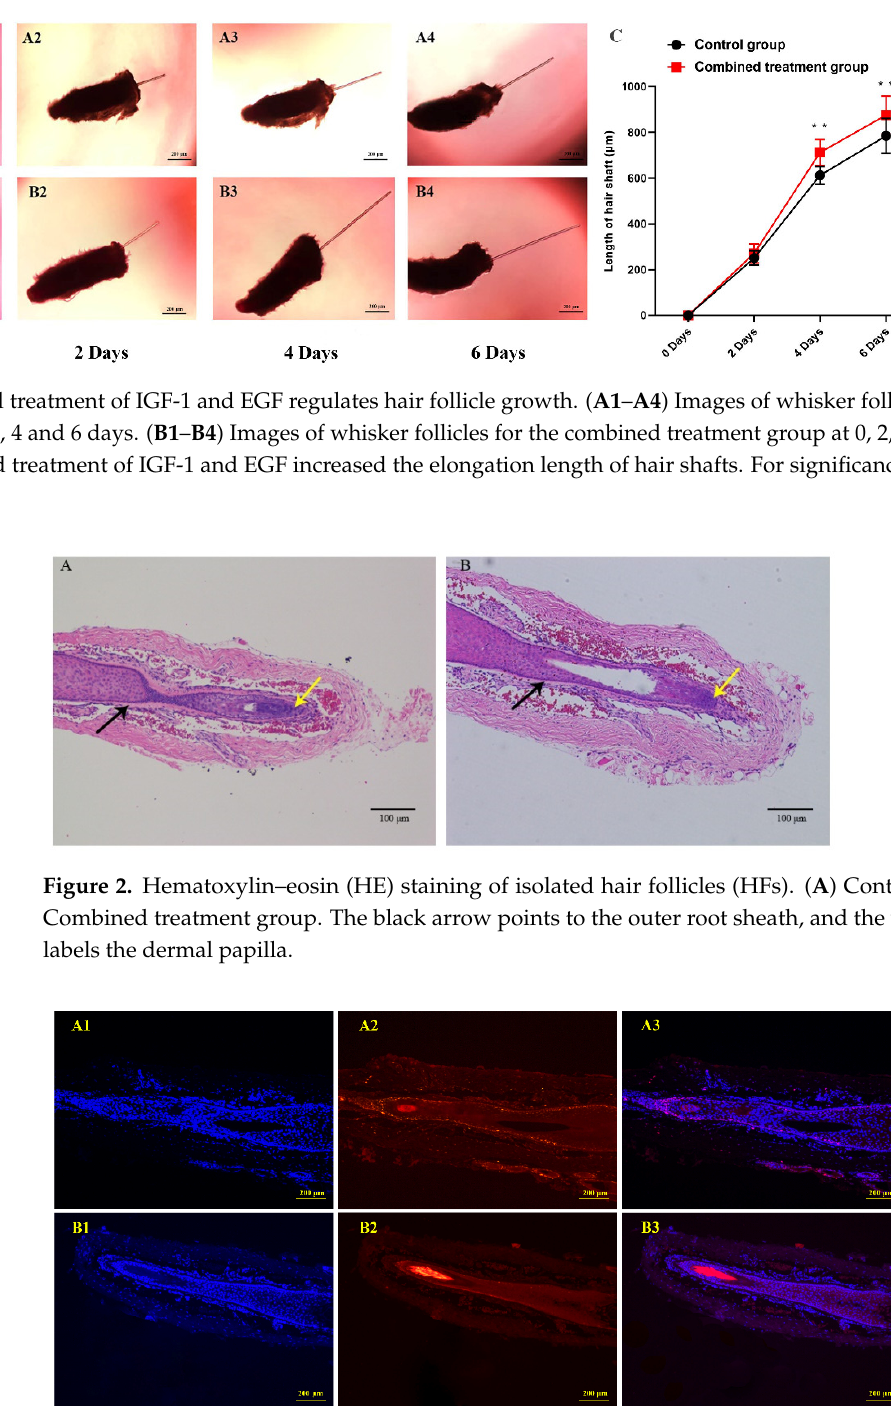
Figure 3. Immunofluorescence analysis of isolated HFs. ( A1-A3 ) Control group ( B1-B3 ) Combined treatment group. DAPI (nuclear) staining (blue) is indicated by 1, 2 indicates proliferating cell nuclear antigen (PCNA) staining (red), and 3 indicates the merged image.